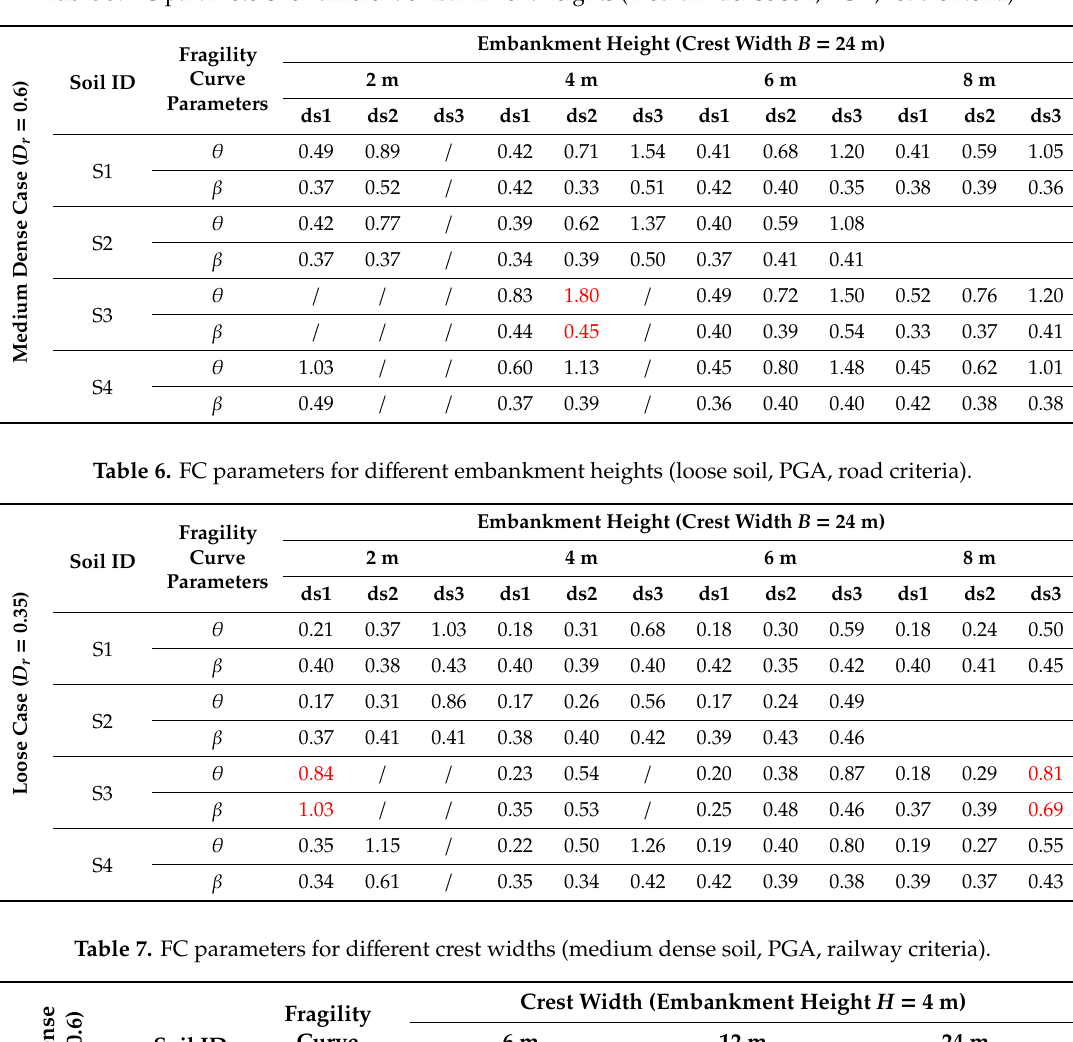
Table 5. FC parameters for di ff erent embankment heights (medium dense soil, PGA, road criteria).